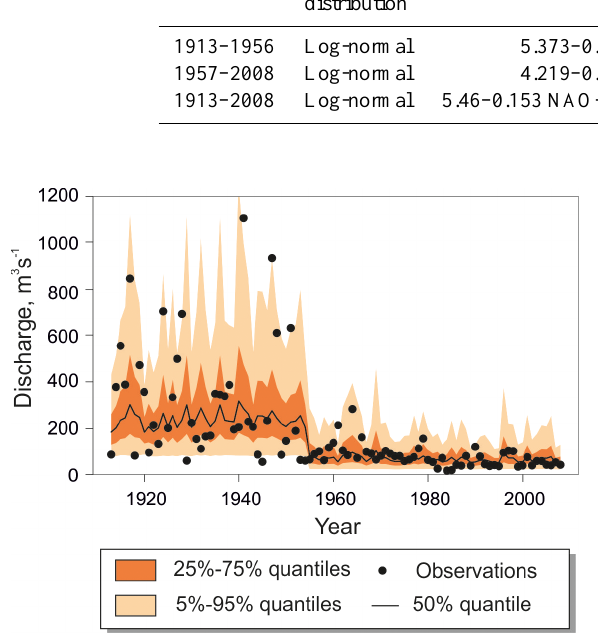
Figure 9. Estimated quantiles for the non-stationary model with the NAO and RI as explanatory variables of the distribution parameters.